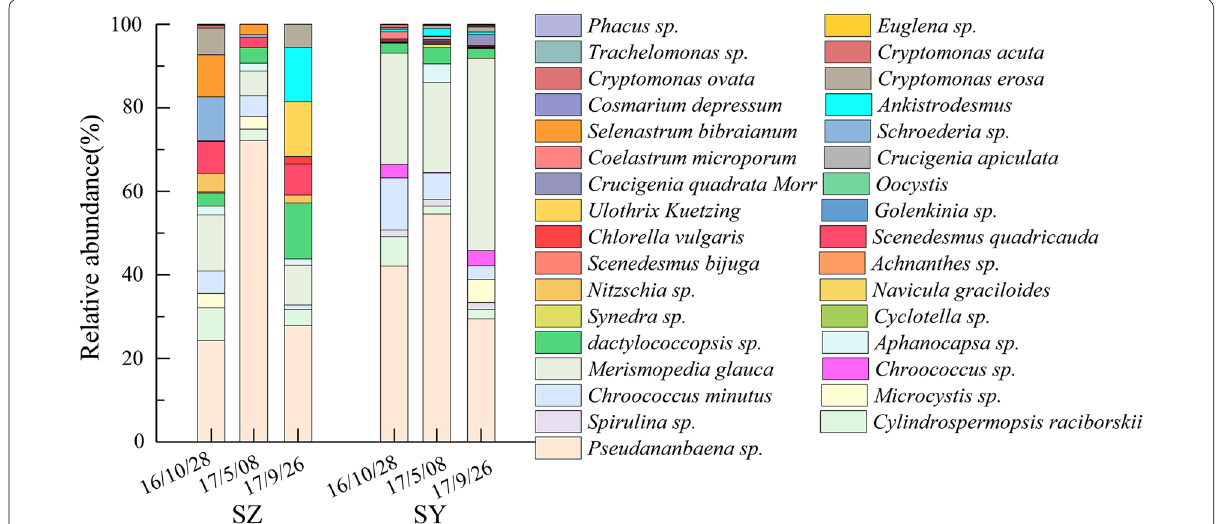
Fig. 3 The variation of phytoplankton in SZ and SY before, after, and during the odor event by genus